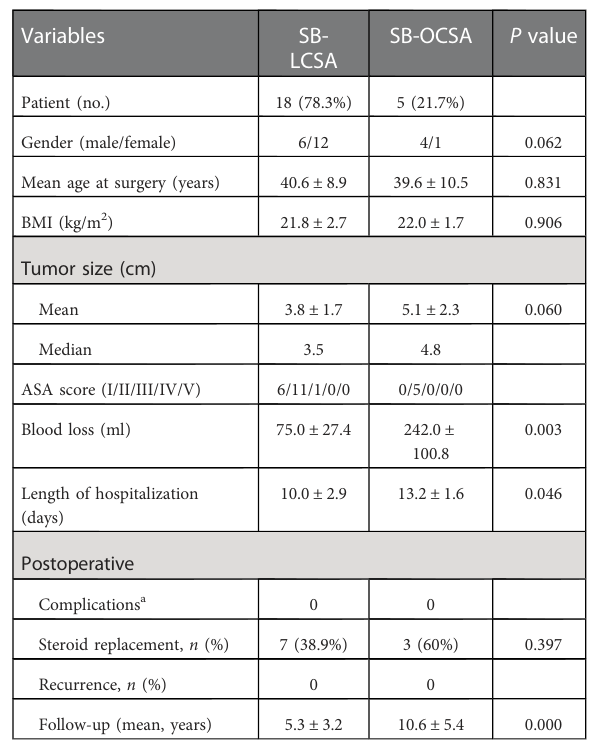
TABLE 4 Factors related to perioperation and postoperation in simultaneous bilateral laparoscopic or open